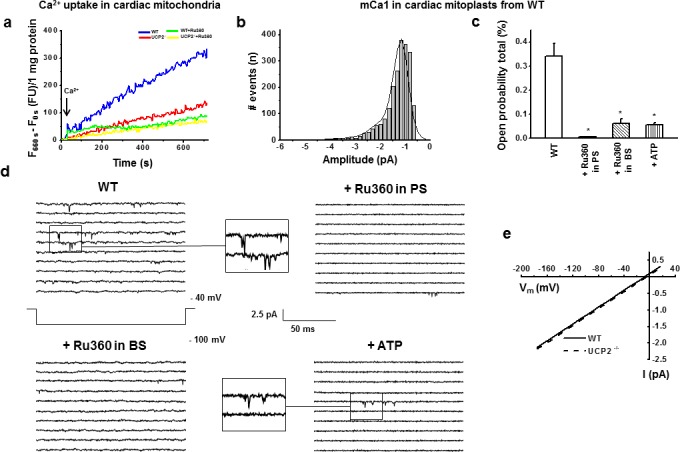
a) Original traces of recordings of Ca2+-uptake in rhod2-AM loaded isolated cardiac mitochondria from WT and UCP2-/- after a bolus of 200 nM Ca2. b) Amplitude histogram of basic mCa1 in mitoplasts from WT. Basic mCa1 in WT showed three amplitude levels with -1.16±0.02 pA being the most common observed amplitude [Iunitary: -1.16±0.02 pA, n = 30; μ1: -1.16 pA (65%), μ2: -1.71 pA (31%), μ3: -3.10 pA (4%)]. c) In cardiac mitoplasts from WT Ru360 (200 nM) in PS (n = 8) and Ru360 (10μM) in BS (n = 5) as well as ATP (1mM) in BS (n = 5) decreased total open probability (Po,total) of mCa1 (*p<0.05). d) Examples of consecutive original traces of cardiac mCa1 in mitoplasts from WT: mCa1 in WT vs. mCa1 in WT + Ru360 (200 nM) in pipette solution (PS) vs. mCa1 in WT + Ru360 (10 μM) in bath solution (BS) vs. mCa1 in WT + ATP (1mM) in BS. e) Slope conductance of mCa1 in WT (12.59±1.57 pS, n = 17) and of mCa1 in UCP2-/- (12.79±1.83 pS, n = 13) was not different.